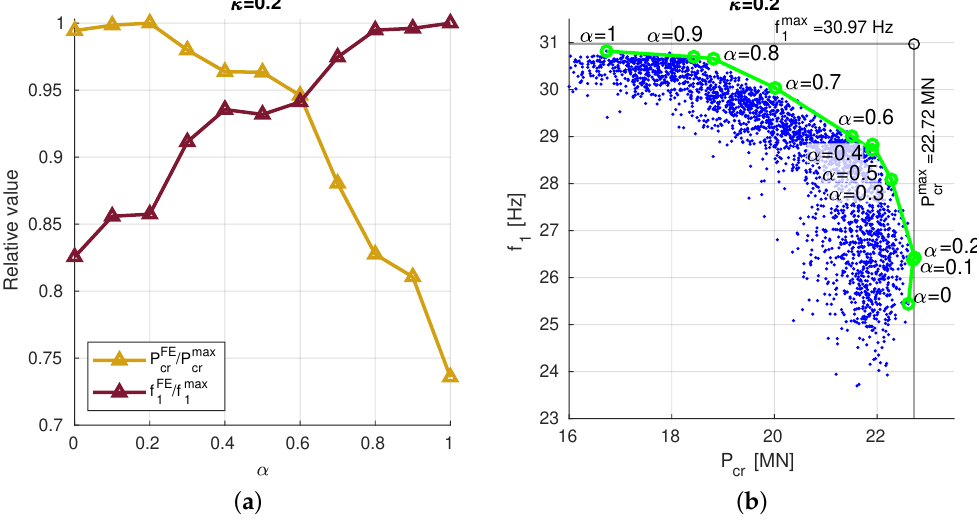
Figure 9. The results of f 1 and P cr optimization, obtained for different values of coefficient α and = P 0 = 1: ( a ) only the best results for each κ , ( b ) all the obtained results, presented constant κ = 0.2, f 0 cr 1 in two-dimensional coordinate system of the results ( P cr - f 1 ).